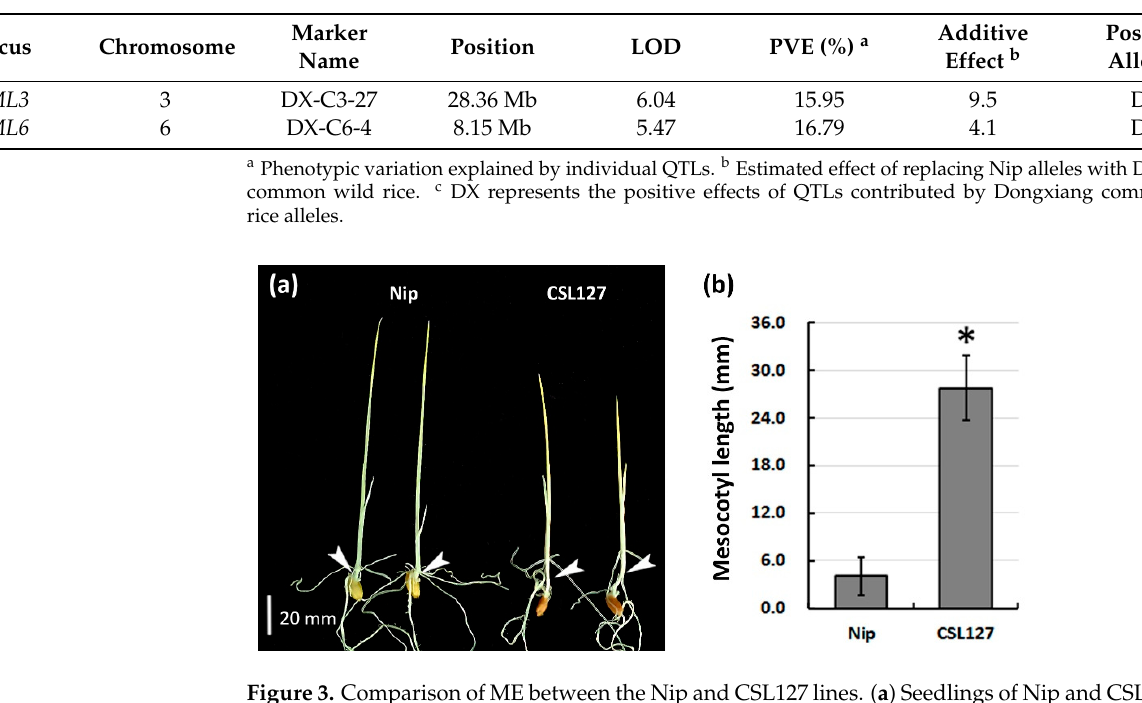
Figure 4. Frequency distribution of the mesocotyl length of plants within the F 2 segregating popu- lation. The black and white triangles represent the mean mesocotyl lengths of the Nip and CSL127 lines, respectively. Figure 5. Confirmation of qML6 via an F 2 segregating population. The position of the significant QTL, qML6-1 , is illustrated by the solid black bar within the chromosome, and the LOD scores are